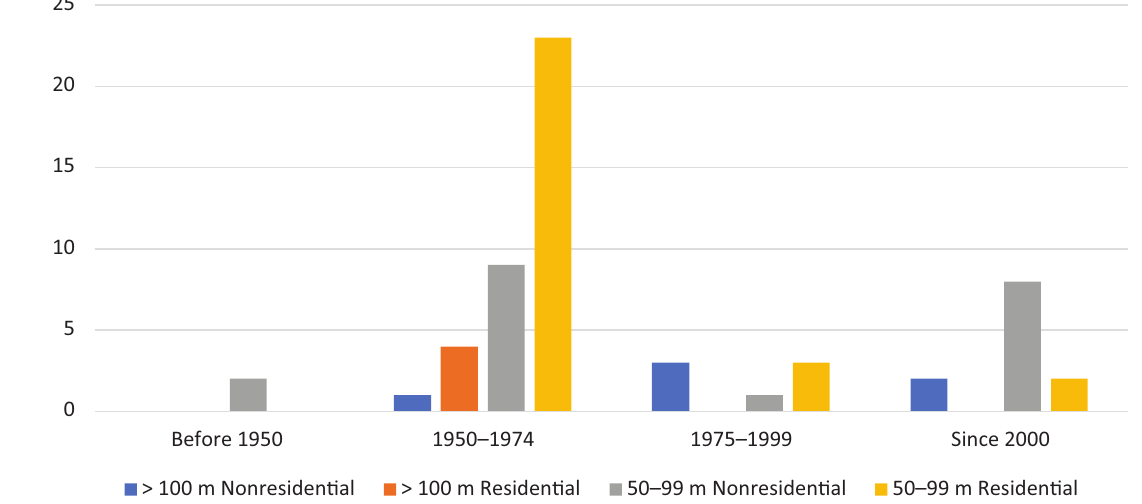
Figure 4. Construction of tall buildings (50 m and above) in Cologne. Sources: Author’s work based on personal observa‐ tions, Hilgenstock (2011), Wikipedia (2022d), and Zabel (2020).